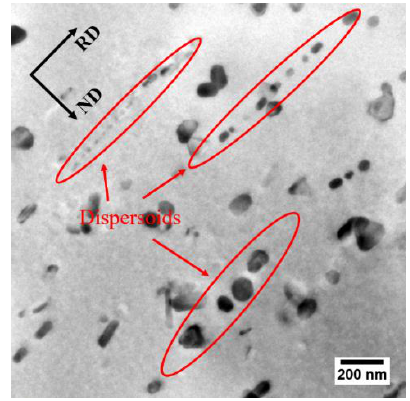
Figure 15. The distribution of dispersoids observed using TEM after solution treatment.